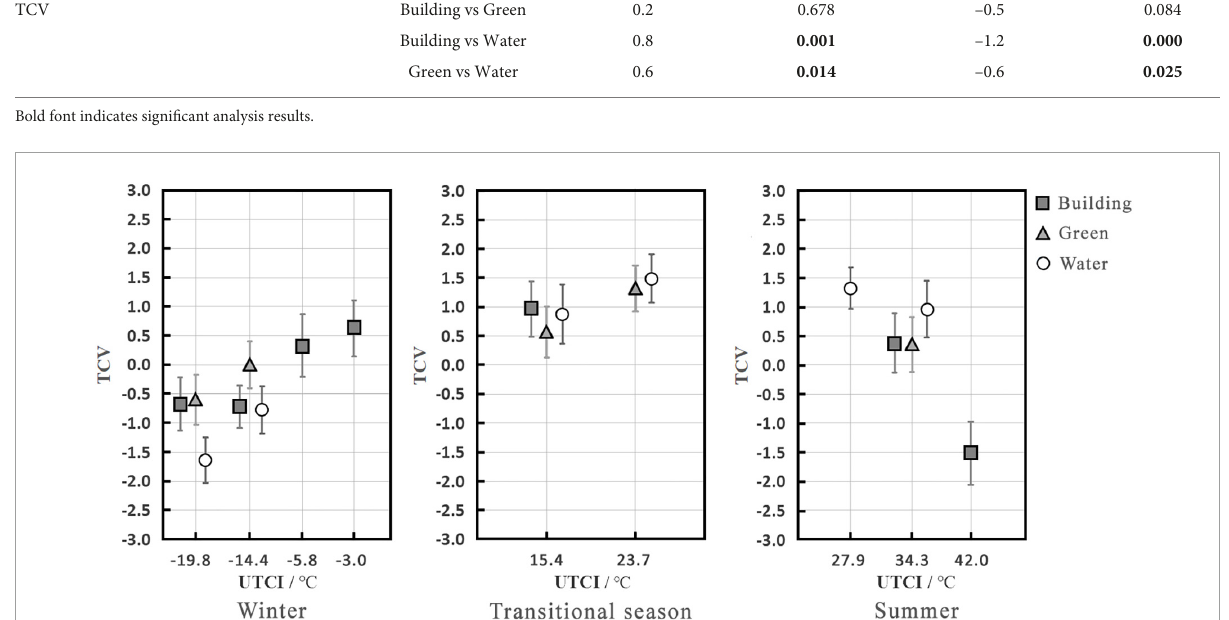
which also explains why the effect of the visual landscape on TCV was the same as that on